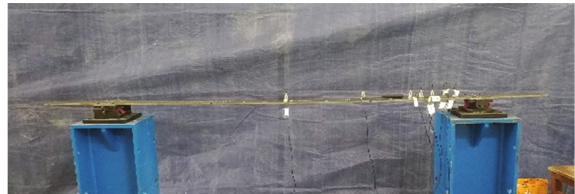
Figure 26: Simply supported steel beam test mode.